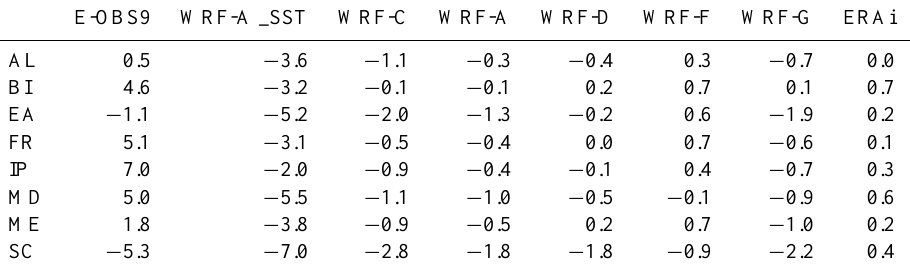
Table 2b. Same as Table 2a for